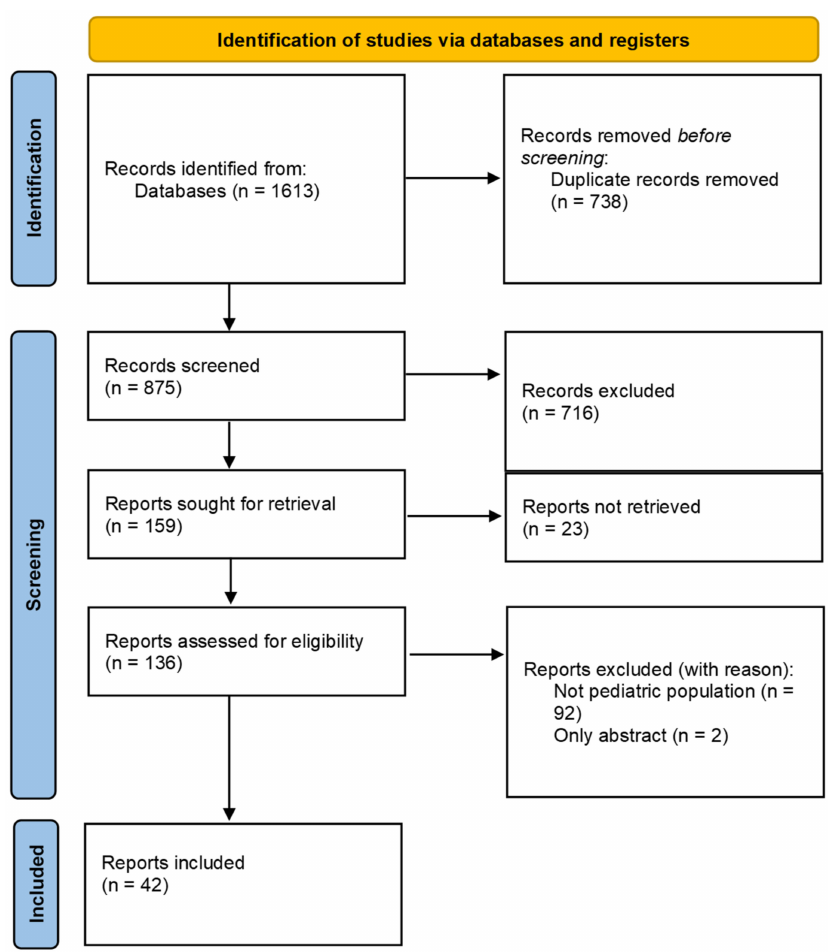
Figure 1. Study selection flow